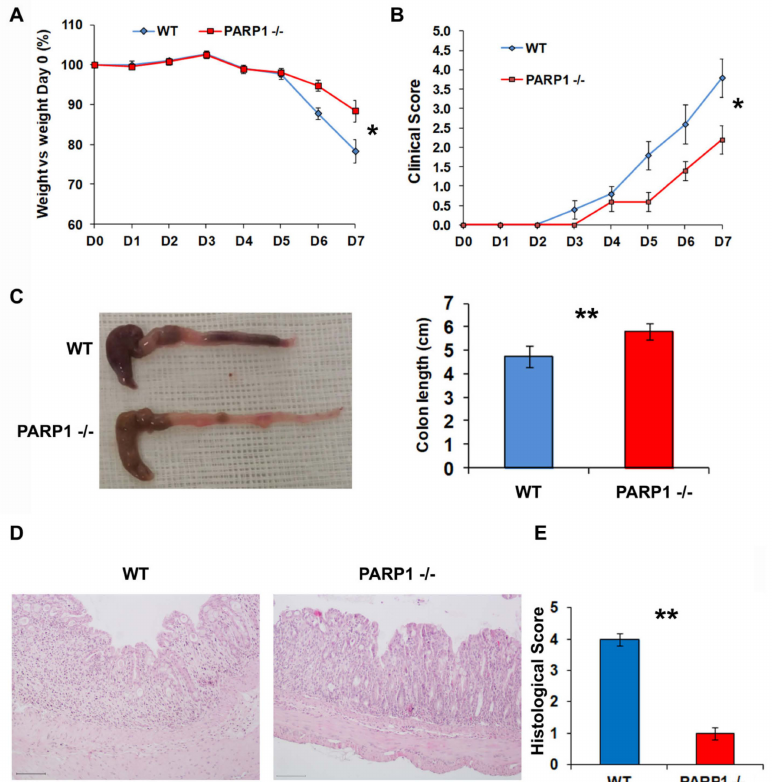
Figure 1. PARP1 − / − mice show less severe colitis than WT mice. PARP1 − / − and WT mice (5 animals per group) were treated with 3% DSS to induce acute colitis that was evidenced by analyzing ( A ) animal weight, ( B ) total animal clinical score, ( C ) animal colon length, ( D ) histology (Scale bar = 100 µ m) and ( E ) histological score. Statistical analysis was performed using the Mann–Whitney U test. * p < 0.05; ** p < 0.01.